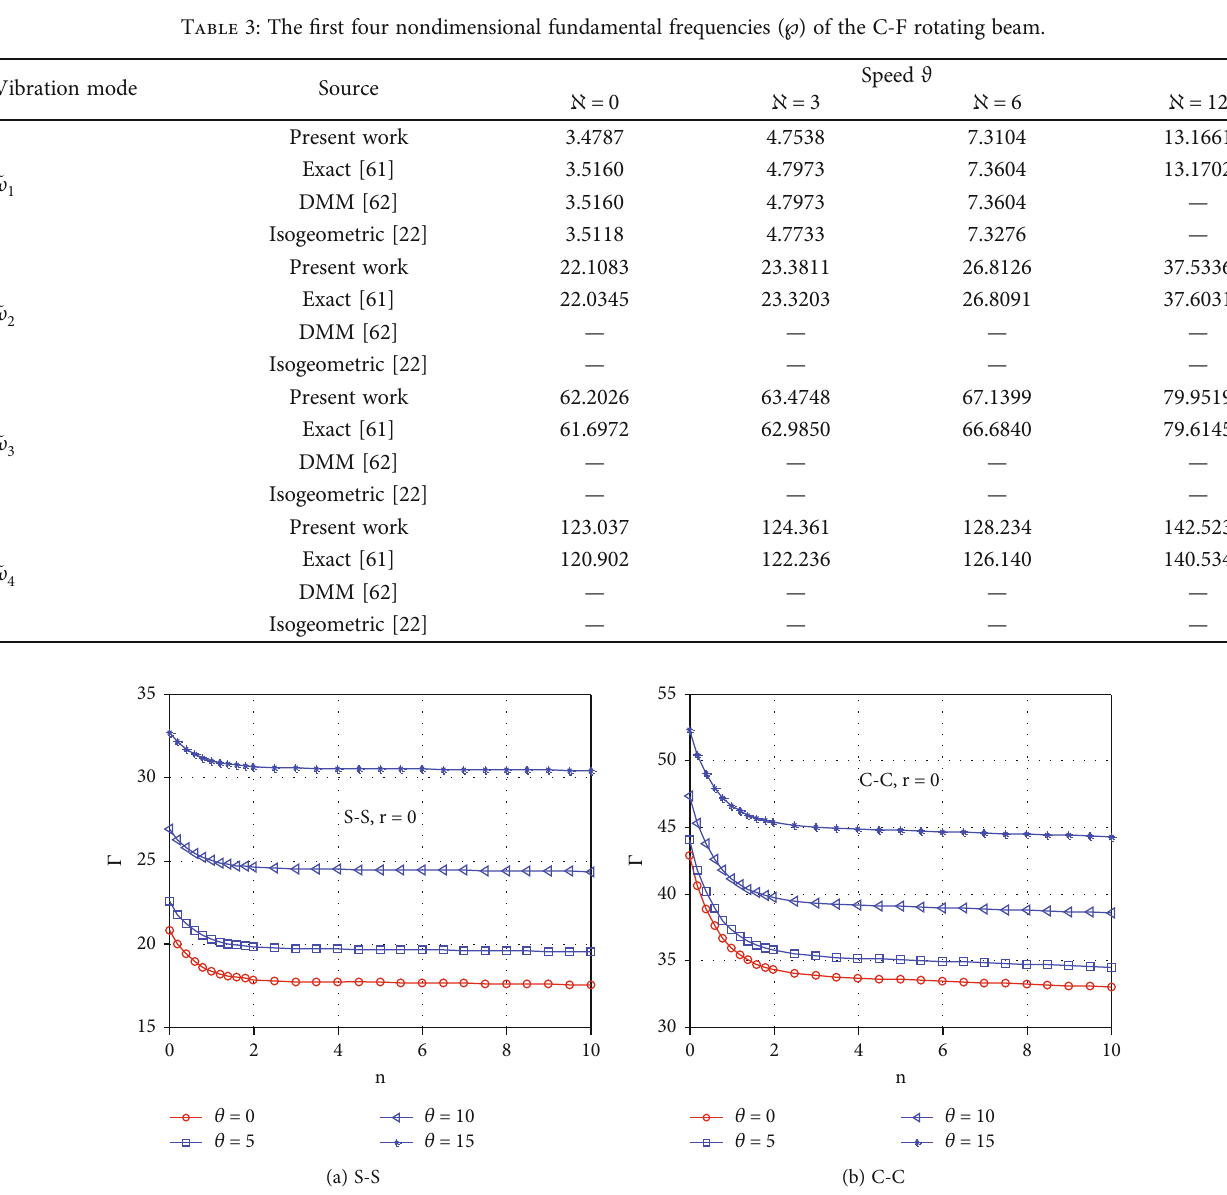
Figure 2: The subordination of the fi rst nondimensional fundamental frequencies of piezoelectric FG beam on the rotational speed and volume fraction index n , K ∗ w = 10 , and K ∗ s = 2